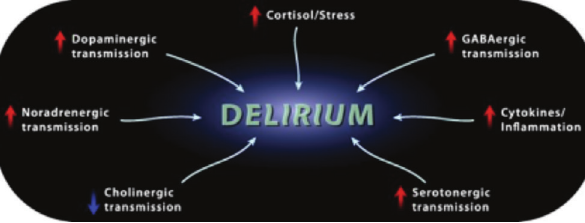
Figure 1: pathophysiology of postoperative delirium